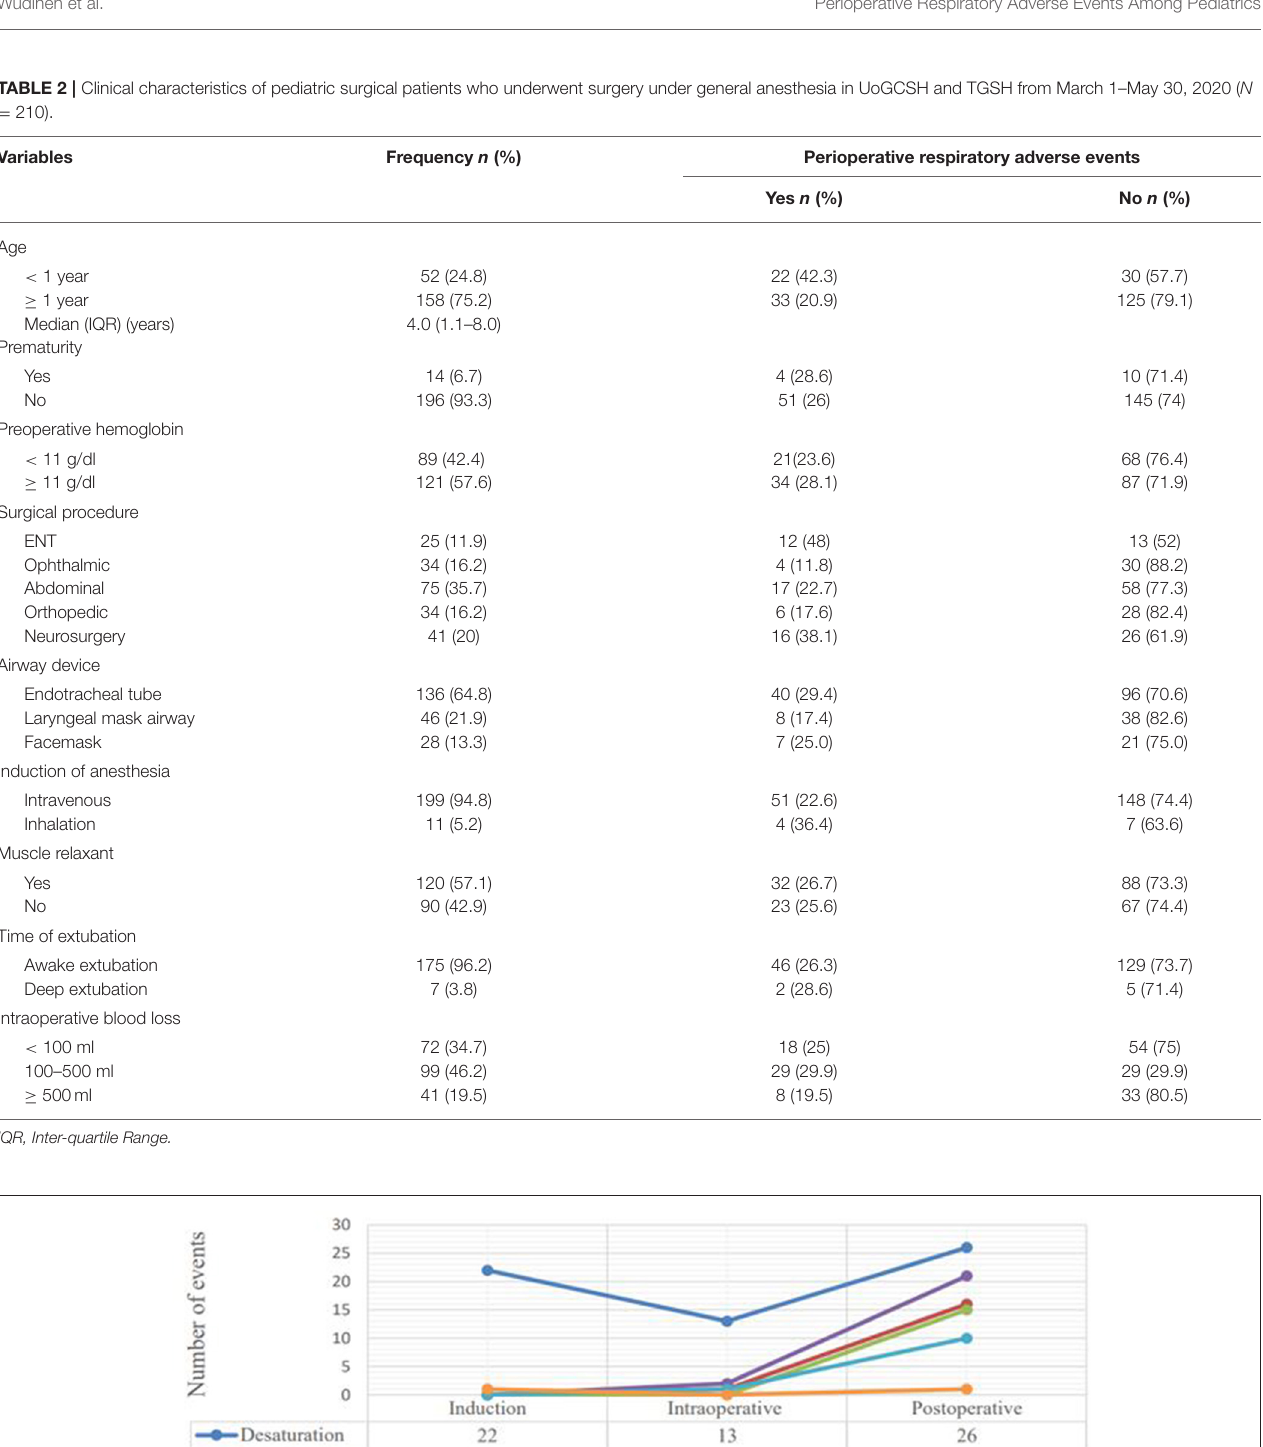
Frontiers in Pediatrics |